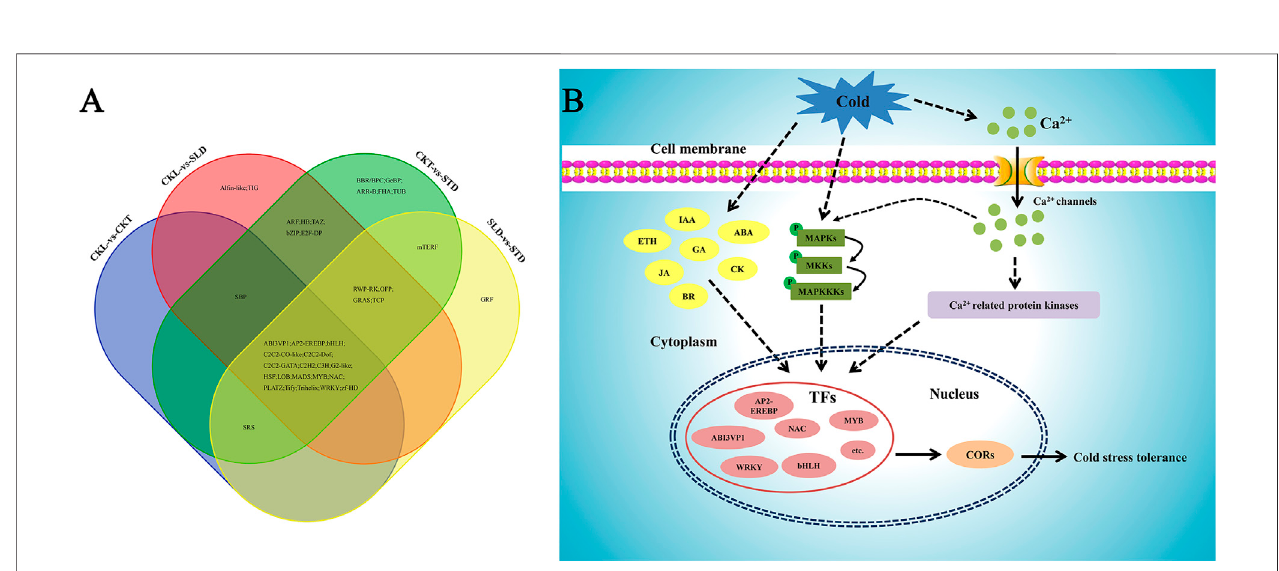
FIGURE8| Venndiagramandspeculativethepathwayof B.rapa inresponsetofreezingstress. (A) Venndiagramofdifferentiallyexpressedtranscriptionfactorsin different combinations before and after freezing treatment. (B) A proposed model of B. rapa in response to freezing stress. Under cold stress, the cell membrane of B. rapa fi rst senses external cold signals, then the signals are transmitted to the nucleus by the MAPK cascades pathway, and many related transcription factors were induced to positively regulate plant freezing tolerance. Meanwhile, changes in hormone levels and Ca 2+ concentration regulate related transcription factors to protect plants from freezing